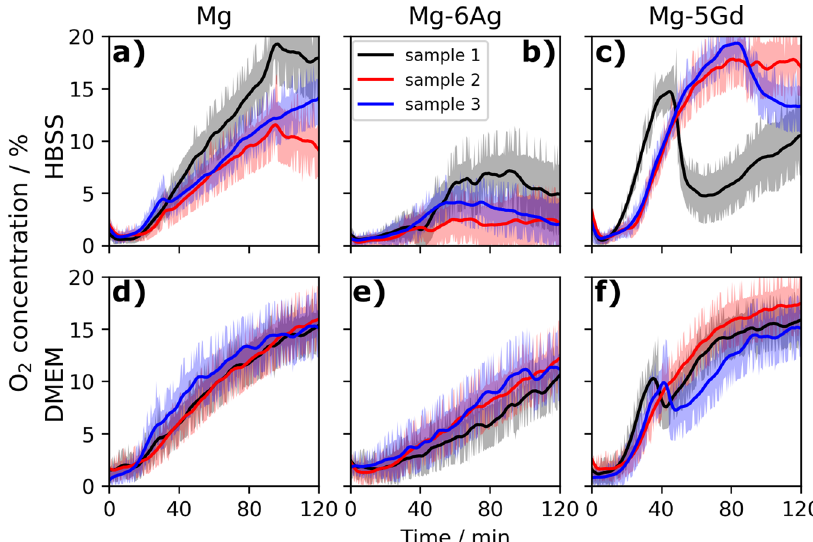
Fig. 3 Filtered mean (solid lines) and standard deviation of O 2 concentration measured in the centre of the metal disc. The O 2 concentration was determined for pure Mg ( a , d ), Mg – 6Ag ( b , e ) and Mg – 5Gd ( c , f ) for three samples each in HBSS ( a – c ) and DMEM ( d – f ).